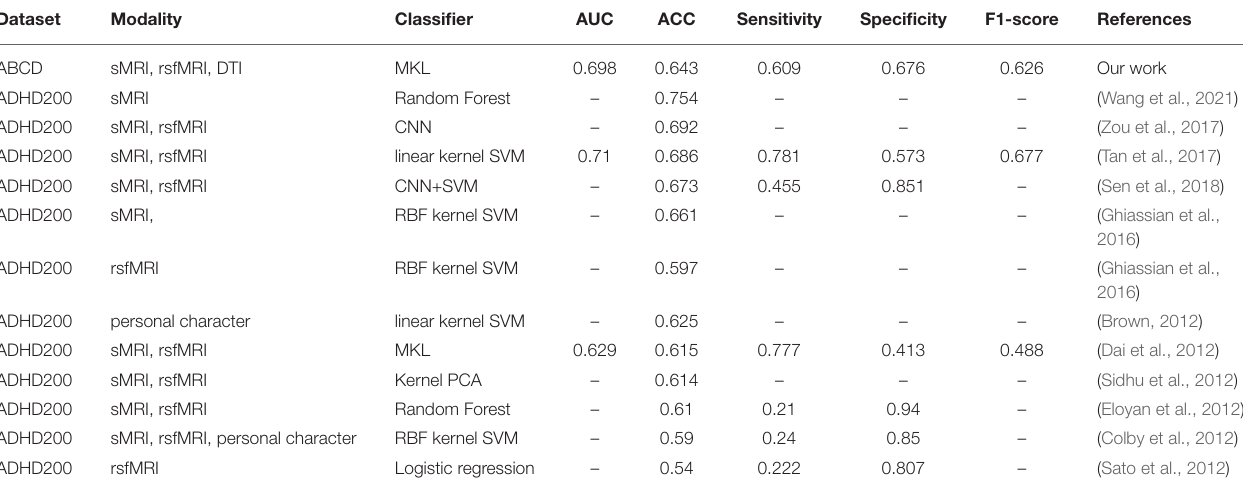
TABLE 5 | Attention-deficit/hyperactivity disorder (ADHD) classification results from published studies.